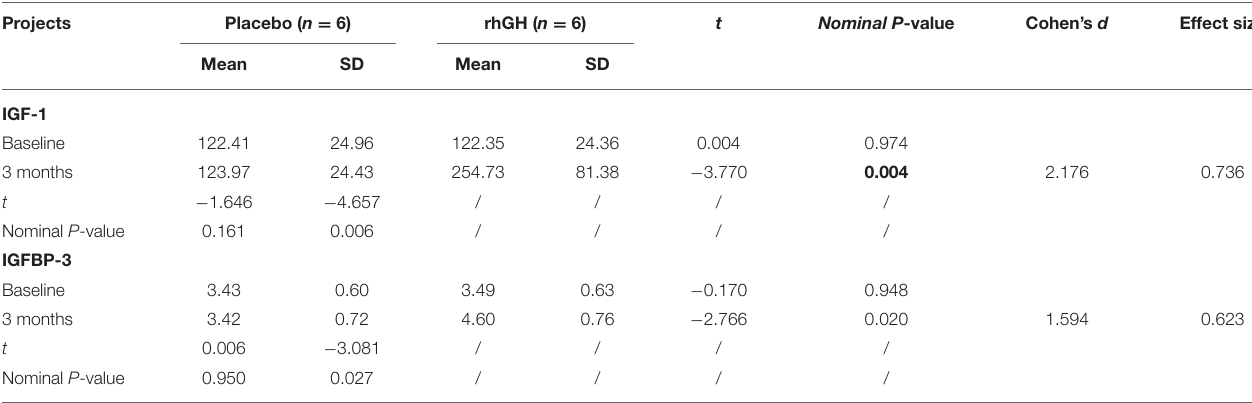
TABLE 8 | Comparison of IGF-1, IGFBP-3 before and after treatment.